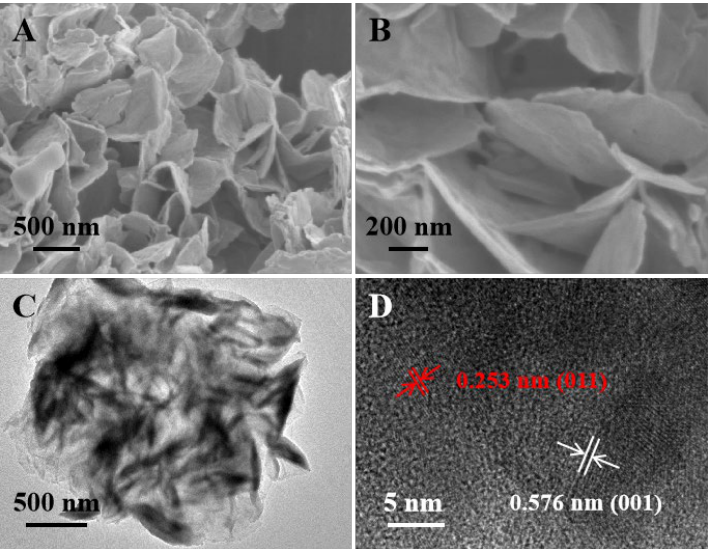
Figure 1. Morphological characterization of VS 2 nanosheets: ( A , B ) SEM images; ( C )TEM image; ( D ) HR-TEM image.